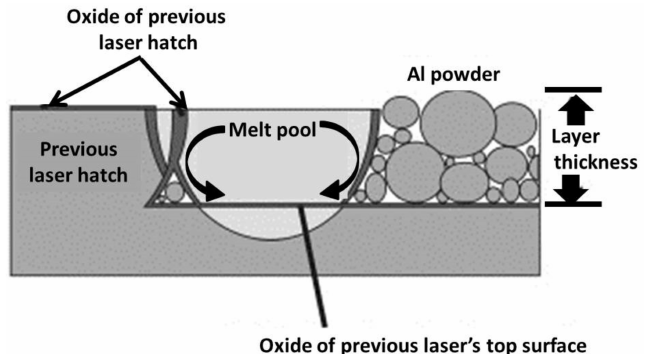
Figure 5. Thin oxide fragments trap gas and unmolten powder particles forming pores (redrawn from ref. [46]).